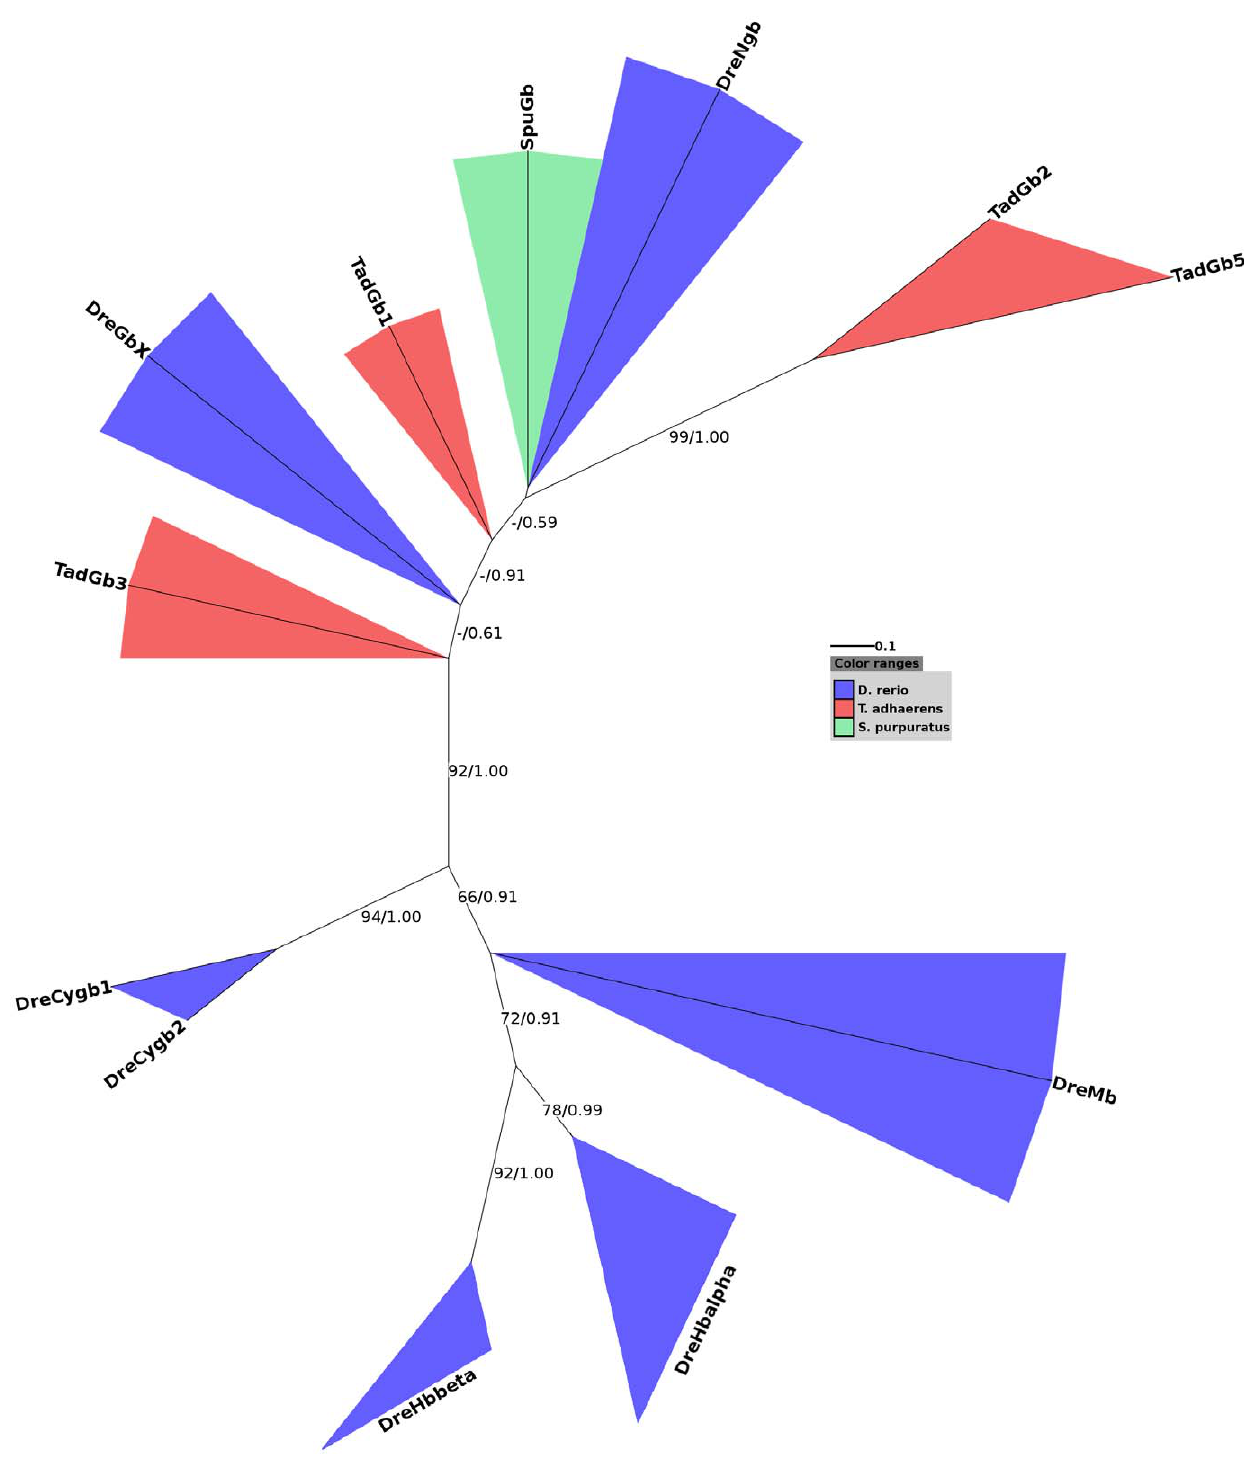
Figure 2. Maximum likelihood tree of several globins from D.rerio , Trichoplax and the sea urchin. Globins from D. rerio , Trichoplax and the sea urchin are highlighted in blue, red and green, respectively. Only one globin domain of the polymeric globin from the sea urchin was used for tree reconstruction. Two globins from Trichoplax (TadGb4, TadGb5) were excluded from this analysis due to doubtful annotation. The RAxML rapid bootstrapping algorithm was used applying 1000 bootstrap replicates. Bayesian posterior probability values are superimposed (bootstrap support/ posterior probability). Only support values above 50% are shown. The clades of a / b -Hb were collapsed. SpuGb and TadGb1, that are located in similar gene neighborhoods as vertebrate Ngb, position next to Ngb and between Ngb and GbX, respectively. For an explanation of abbreviations please see Table S1.